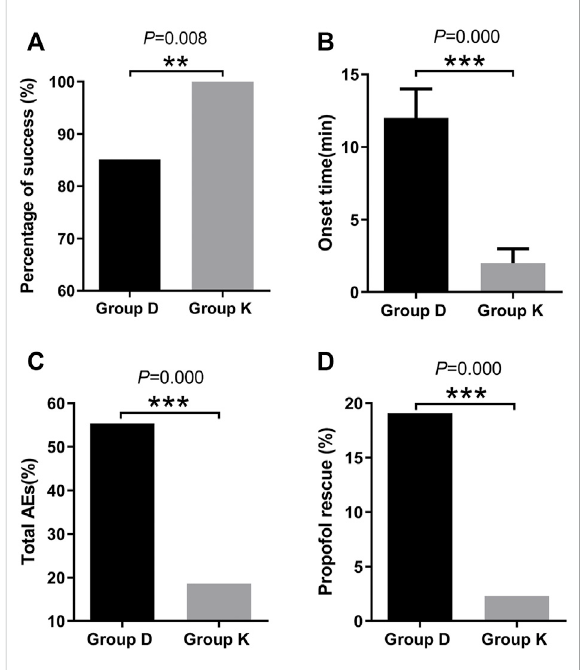
FIGURE 4 Different effects of two groups during drug-induced sleep endoscopy in children with obstructive sleep apnea hypopnea syndrome. (A) Percentage of success. (B) Onset time. (C) Total AEs. (D) Propofol rescue. Data are expressed as median (interquartile range) or frequency (%), Compare between two groups * p < 0.05, ** p < 0.01, *** p <